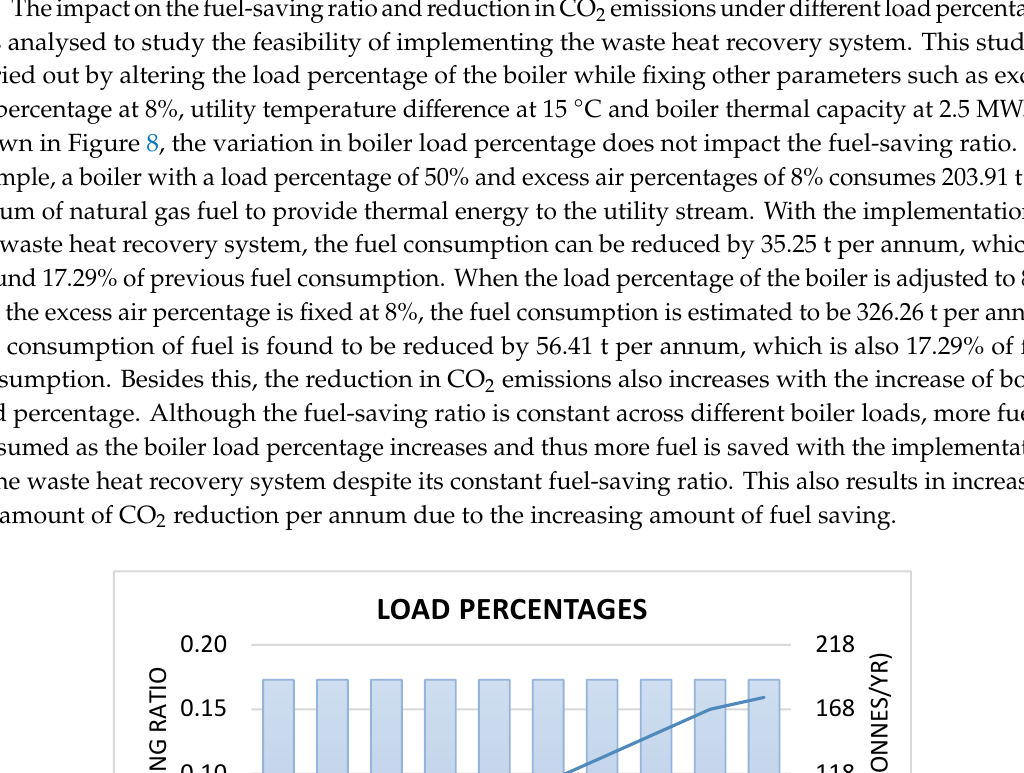
Figure 8. Fuel-Saving Ratio and CO 2 Reduction under Different Load Percentages